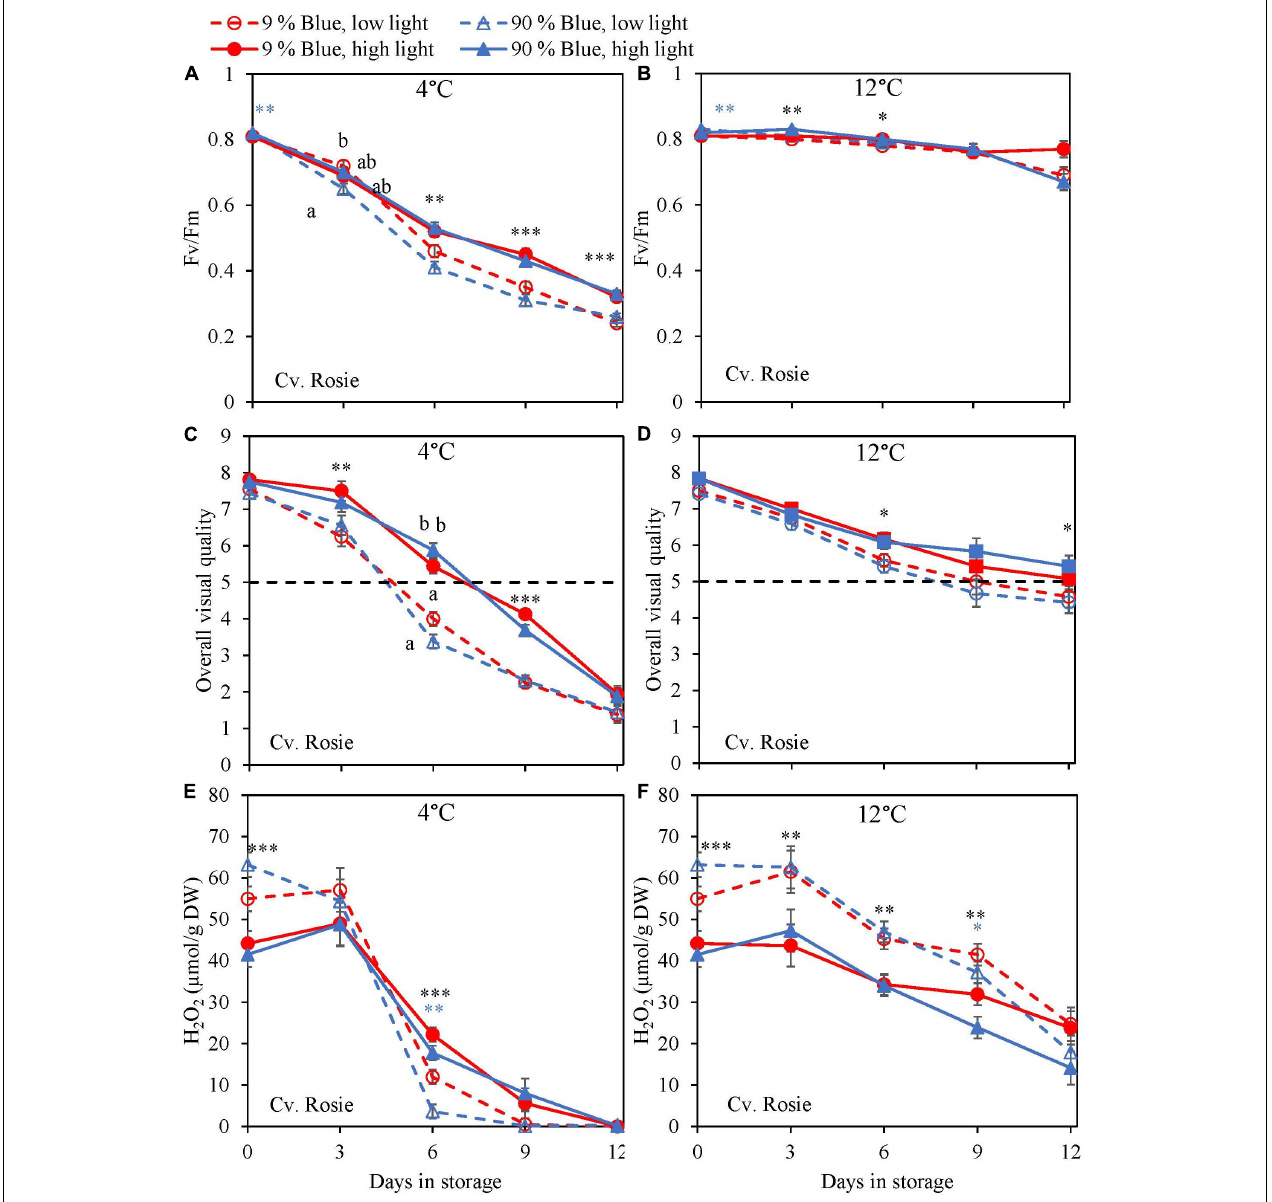
FIGURE 7 | Changes in chilling injury parameters during postharvest storage at 4 (A,C,E) and 12 ◦ C (B,D,F) in basil in the purple cv. Rosie was exposed to EOP treatments. Plants were grown under red-white light (PPFD of 200 µ mol m − 2 s − 1 , 9% blue) for 30 days. The last 5 days before harvest plants were exposed to different EOP blue light ratios 9 or 90% at low light (100 µ mol m − 2 s − 1 ) (open symbols) or high light (300 µ mol m − 2 s − 1 ) (closed symbols). (A,B) Change in Maximum quantum yield of PSII of dark-adapted leaves (F v /F m ), (C,D) change in OVQ, (E,F) change in H 2 O 2 content. All metabolite values are expressed per gram dry weight in leaves. The data are means of four blocks ( n = 4) (i.e., per block four replicate plants). Standard errors of means are shown as error bars. If no interaction was found but only the main effects were significant the indicated with p -values; ∗ p < 0.05, ∗∗ p < 0.01, ∗∗∗ p < 0.001 are depicted with either a blue (percentage of blue light) or black asterisk (PPFD). Letters indicate and interactive effect between the two main effects (percentage of blue light and PPFD), (Experiment 2).